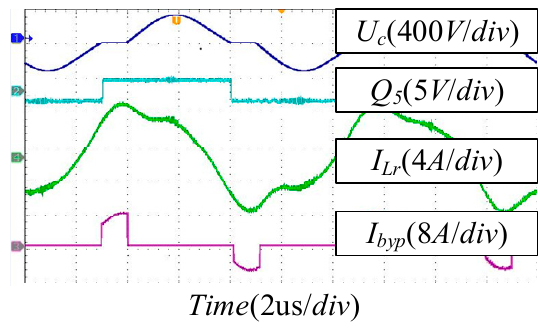
Figure 12. Key waves in switching diagram.